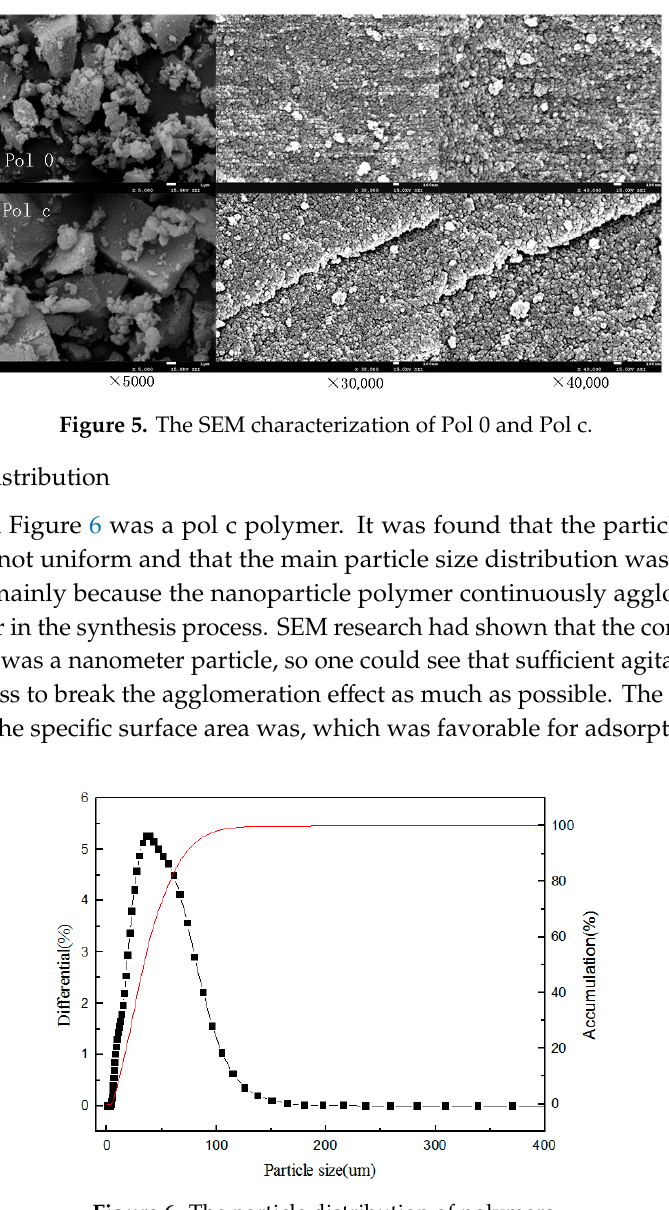
Figure 6. The particle distribution of polymers.